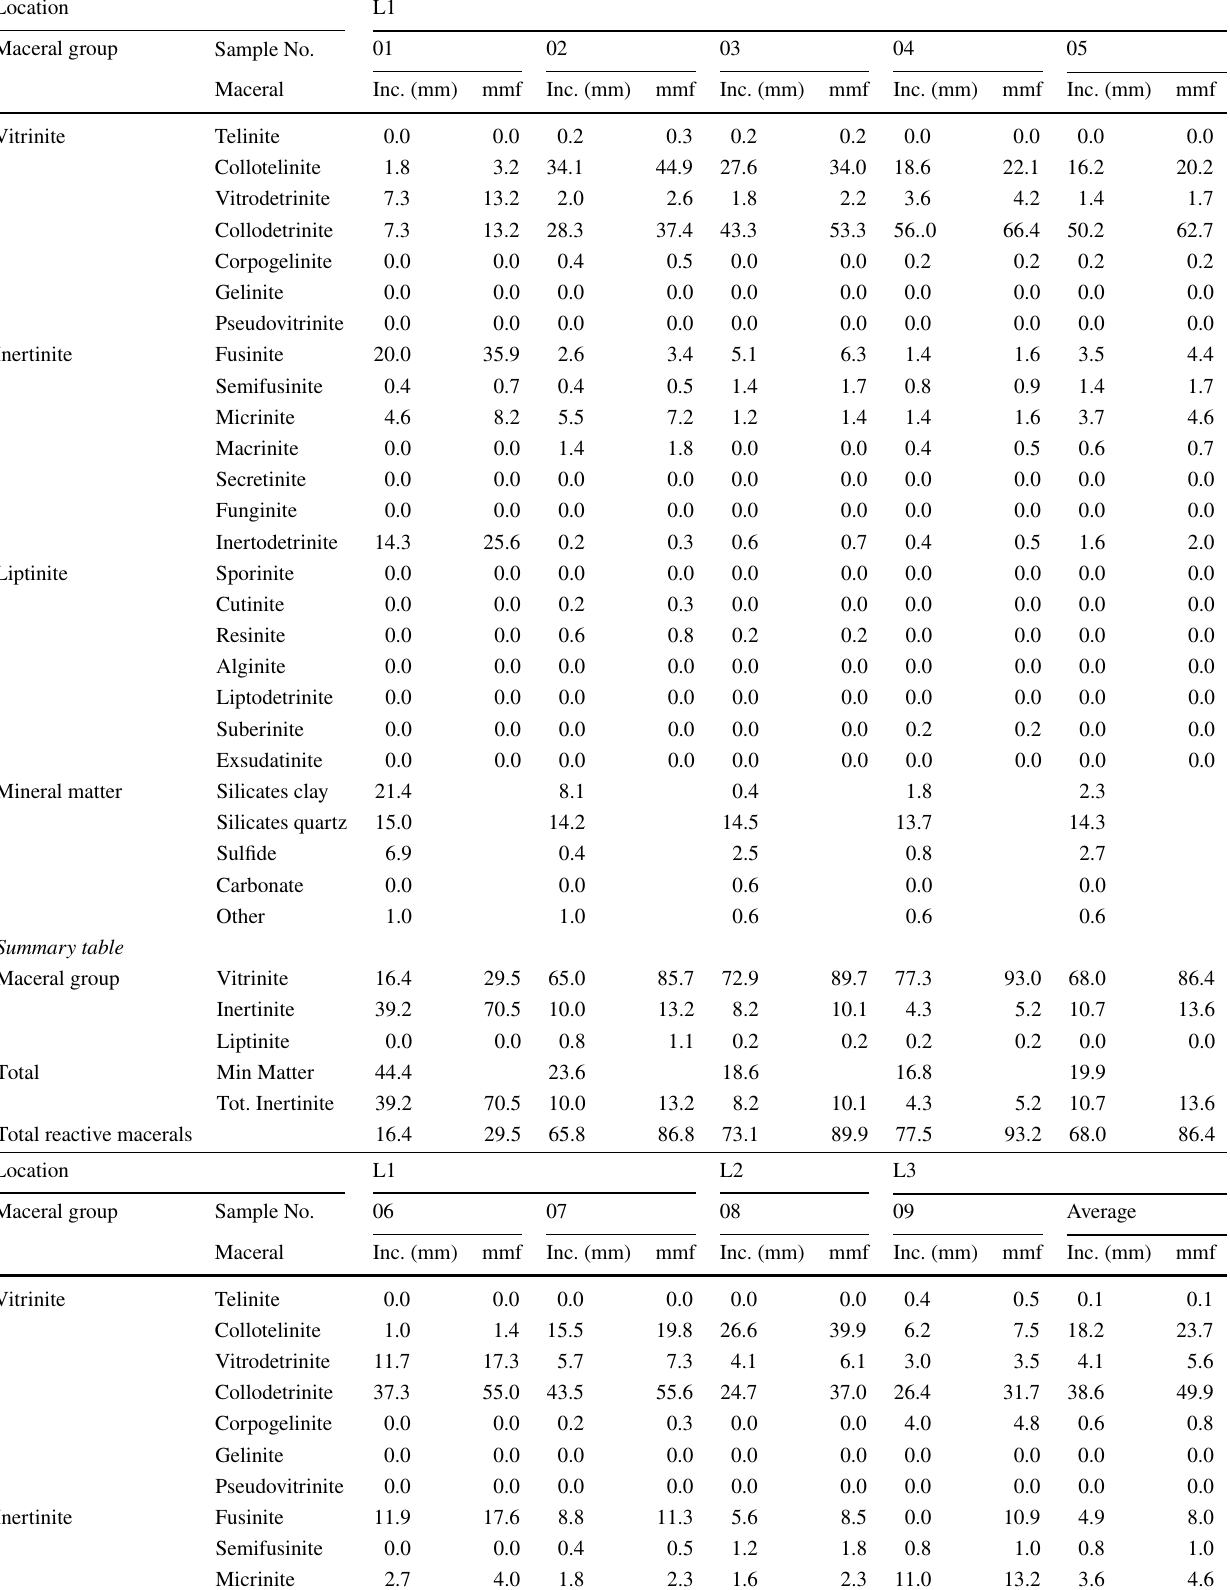
Table 6 MBT petrographic results: Maceral and mineral composition (% by volume) (Inc = mineral matter inclusive; mmf = mineral matter free) Location L1 Maceral group Sample